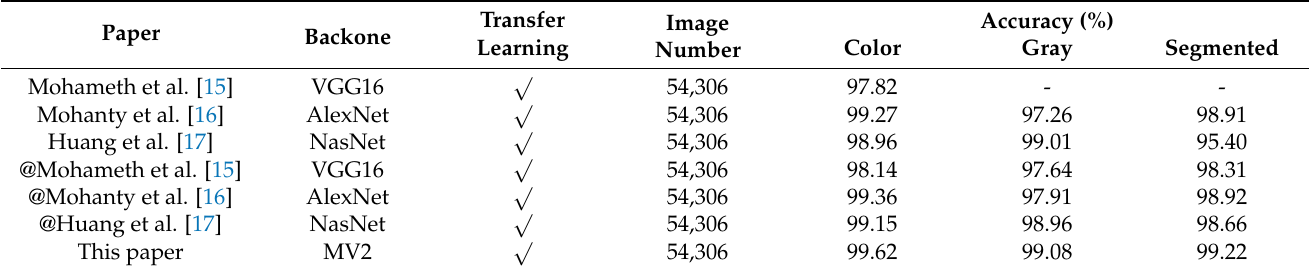
Table 3. Comparisons of recognition accuracy of different models on three versions of Plant